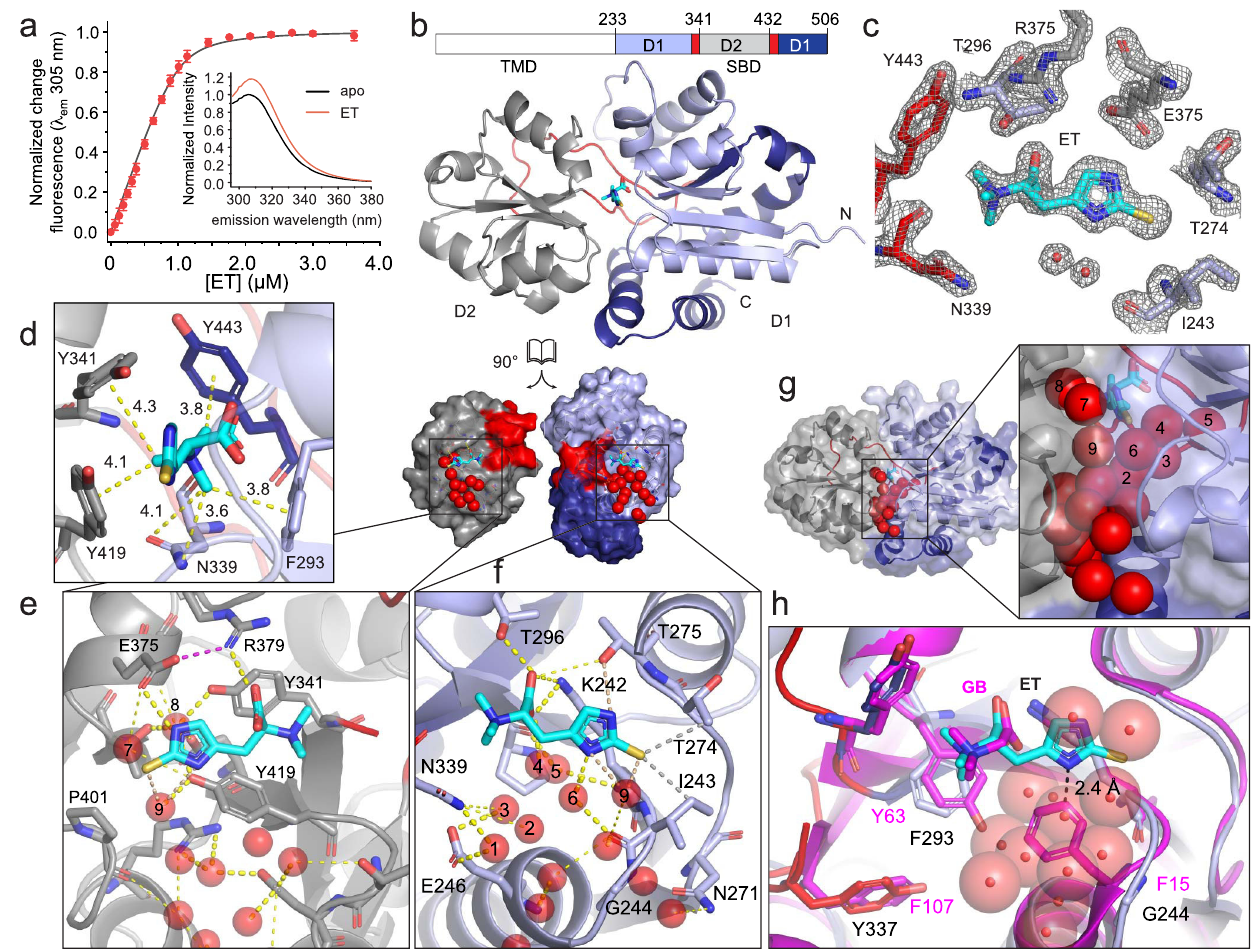
Fig. 2 | Structure of ET-bound Sp EgtUC. a Titration of ET into 1.0 µ M Sp EgtUC monitored by changein intrinsic Tyr fl uorescence. Each titration point isshown as the mean and standard deviation of three independent replicates. Inset , tyrosine emissionspectraof Sp EgtUCintheabsence(black)andpresence(red)ofsaturating ET. b CrystalstructureofET-boundEgtUC CTT shownasribbon,withD1shadedlight blue (residues 232 – 331) and dark blue (445-503), D2 shaded gray (341-432) and linkers colored red. ET is shown as cyan sticks. c Electron density map of ET and surrounding residues in the ligand binding pocket. d Quaternary amine region of theETbindingpocket,withresiduesinthearomaticpentagonshownassticks,with polarandcation – π interactionsshownasyellowdashedlines,withdistancesshown in Å. e ET binding pocket of D2, with backbone ribbon colored as in a . Water